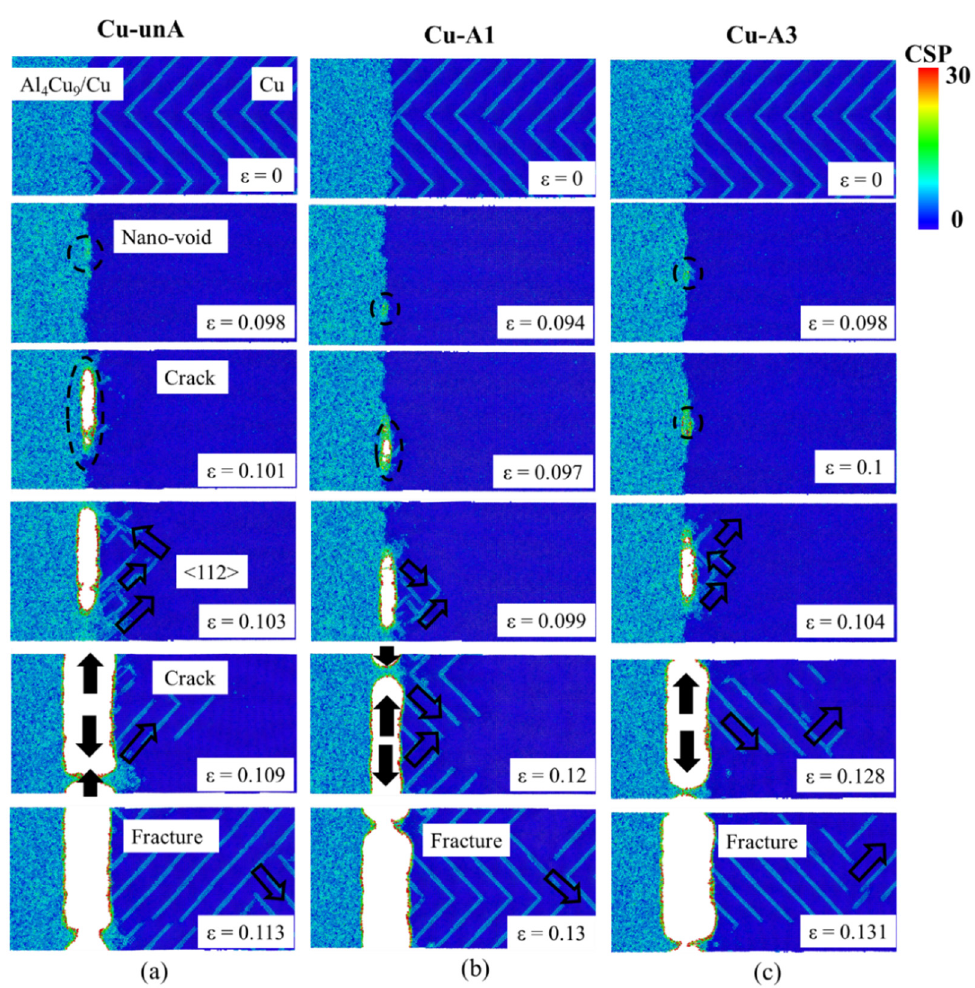
Figure 14. CSP analyses for ( a ) Cu-unA, ( b ) Cu-A1, and ( c ) Cu-A3 at different strain values. (The unfilled and filled arrows denote the dislocation and crack propagation direction, respectively).